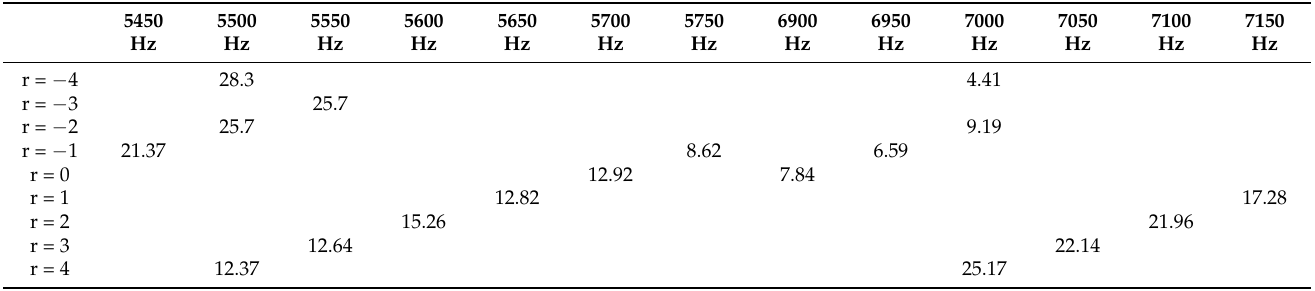
Table A4. Frequency, order and amplitude of electromagnetic force wave under 30% dynamic eccentricity operating conditions (5450–7150